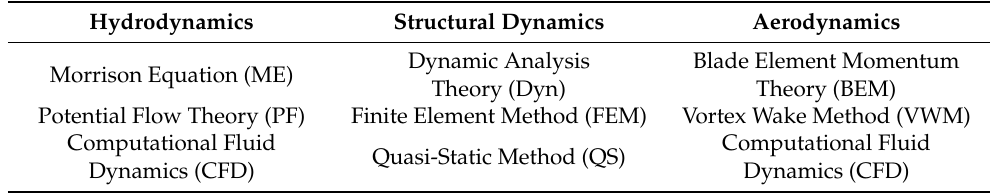
Table 2. The fundamental theory of wind and wave coupling